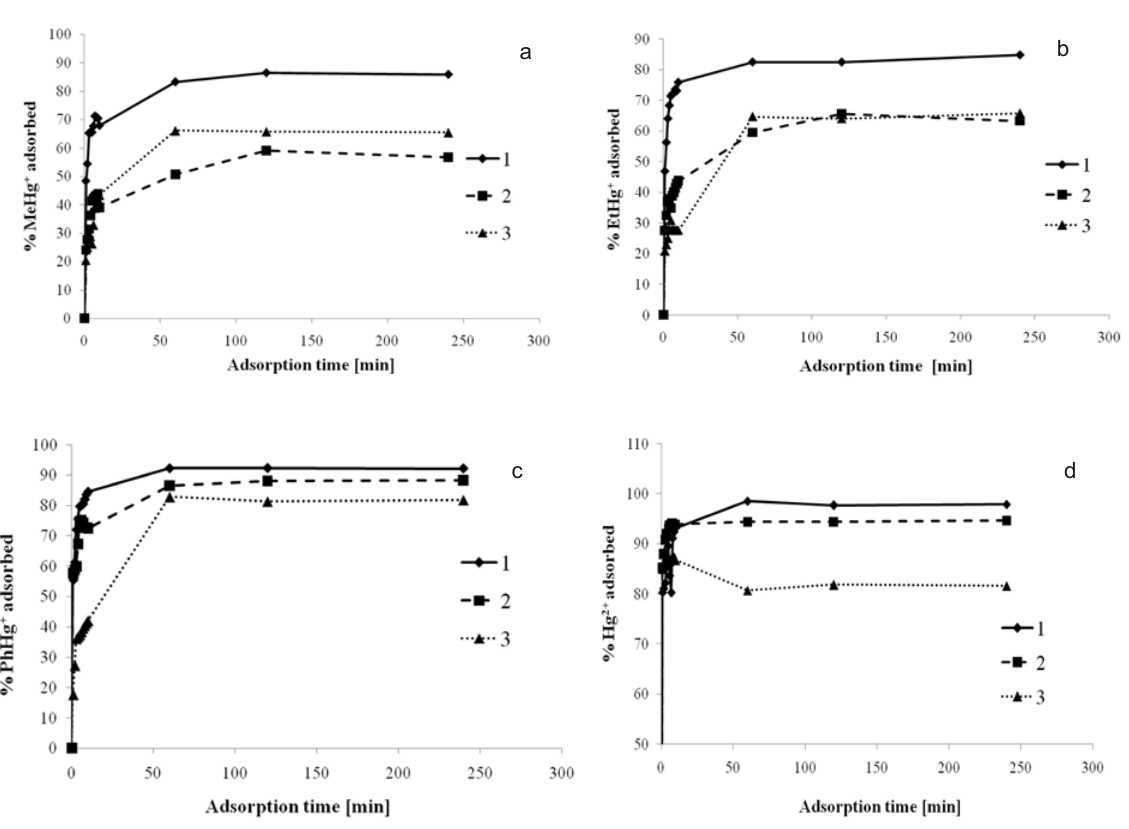
Figure 6. Effect of Zn 2+ and Fe 3+ at pH 5.2 (agitated system, 20 g of ZL 1606 sediment, 250 mL of water, pH = 5.2, Hg concentration 0.2 mg L -1 , T = 22.3°C); (1) without cation addition, (2) 0.2 g L -1 Zn2+, (3) 0.2 g L -1 Fe